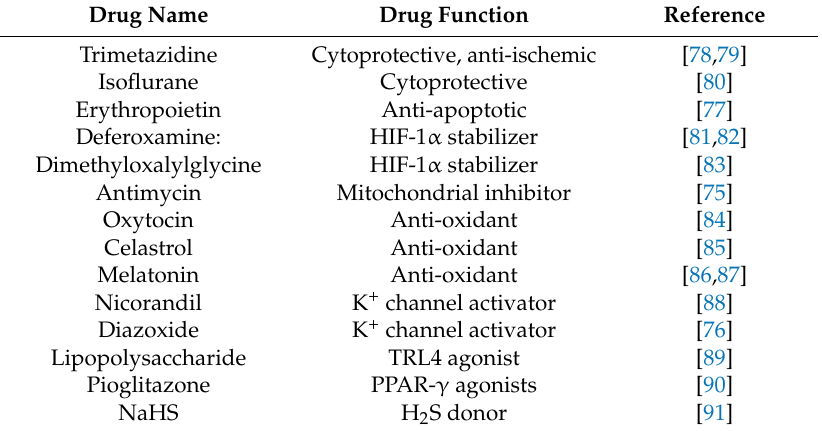
Table 2. Pharmacologic mesenchymal cell